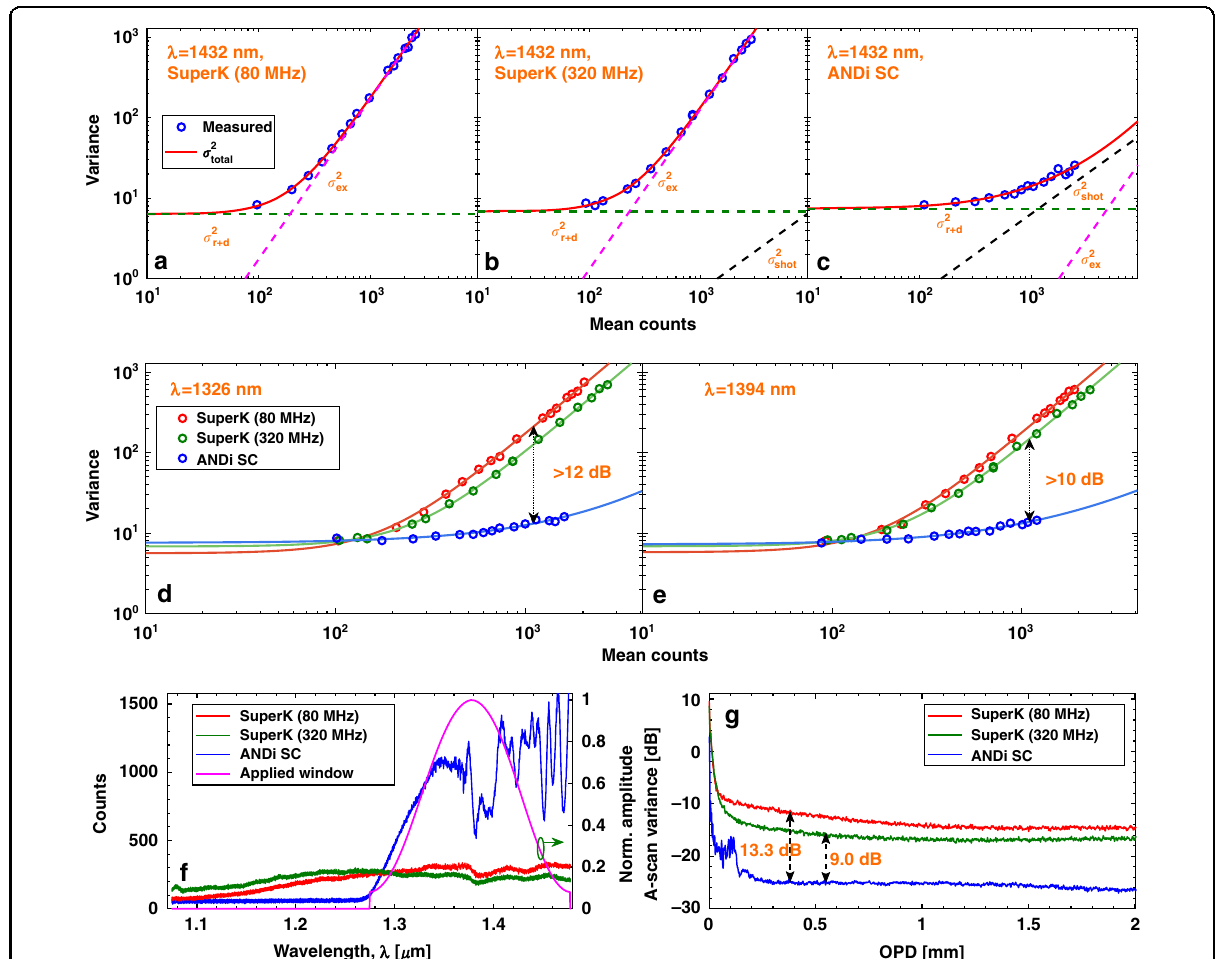
Fig. 2 OCT system noise characterization. The variance in counts versus the mean counts (over 1024 measurements) at 1432 nm for the 80 MHz SuperK extreme ( a ), 320 MHz SuperK extreme ( b ), and ANDi SC source with 90 MHz repetition rate ( c ). Comparison of the variance in counts versus the mean counts for the 80 MHz SuperK extreme, 320 MHz SuperK extreme, and ANDi SC source with 90 MHz repetition rate at 1326 nm ( d ), and 1394 nm ( e ). Spectral counts across the spectrometer bandwidth for the three sources, when the counts at 1432 nm is fi xed at the optimum value for imaging (250 counts for SuperK extreme sources and 1000 counts for the ANDi SC source) ( f ). The magenta curve shows the window used in the signal processing. g Corresponding variance in A-scans over 1024 measurements. In ( d – g ) the 80 MHz SuperK extreme, 320 MHz SuperK extreme, and ANDi SC source are shown as red, green, and blue curves, respectively. All measurements are taken with blocked sample